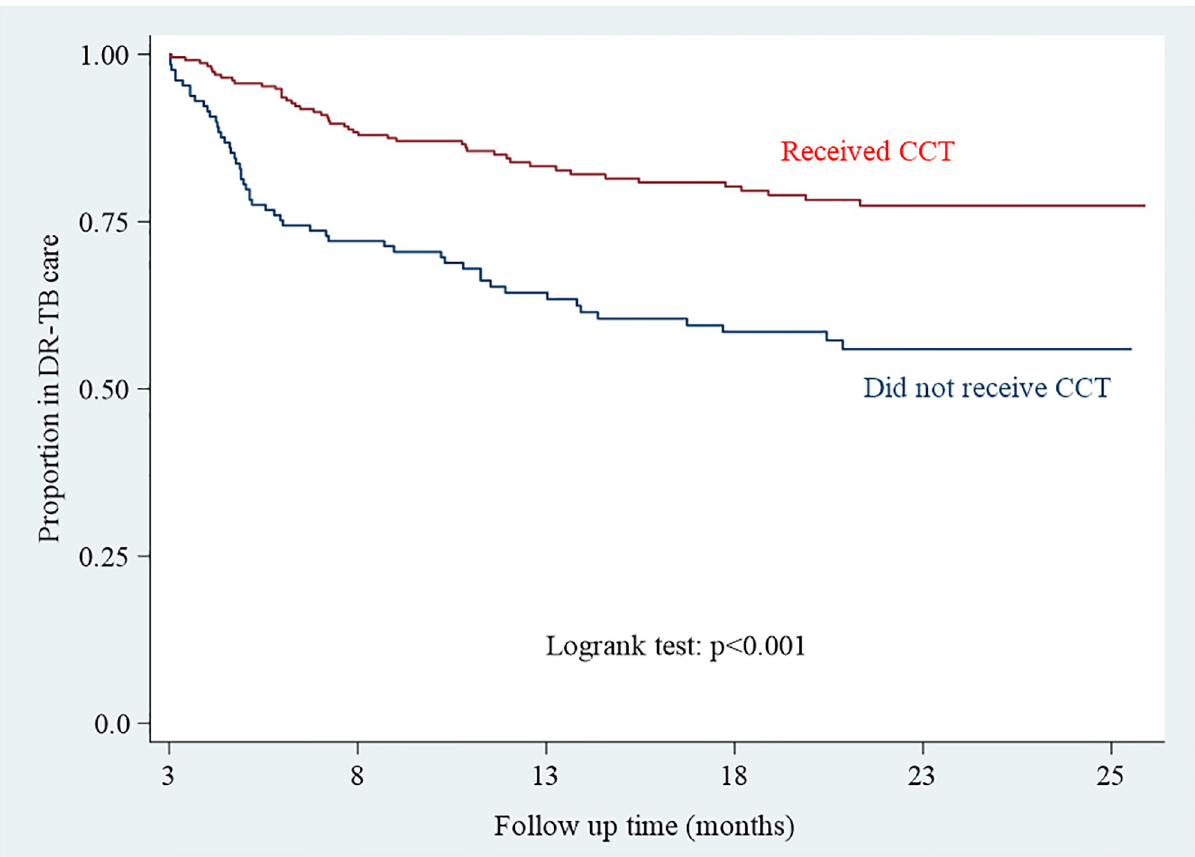
Fig 3. Time to unsuccessful outcomes among people with DR-TB, by registration status for CCT, 2014–2021, Zimbabwe.